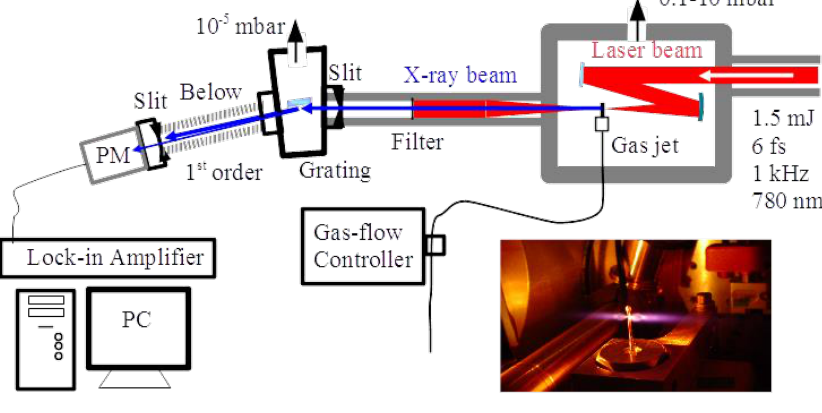
Figure 3. Experimental setup with the 1-kHz Ti:sapphire laser system with a picture of the He gas jet. PM, photomultiplier. For the details, see the